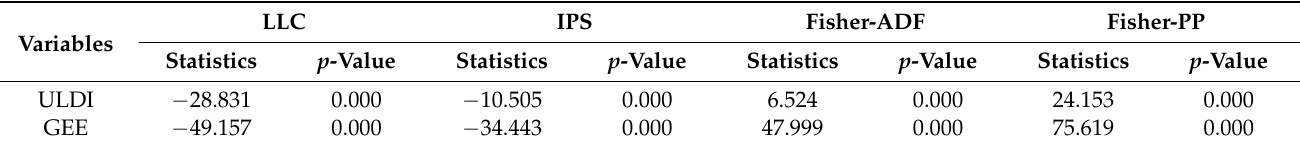
Table 3. Unit root test